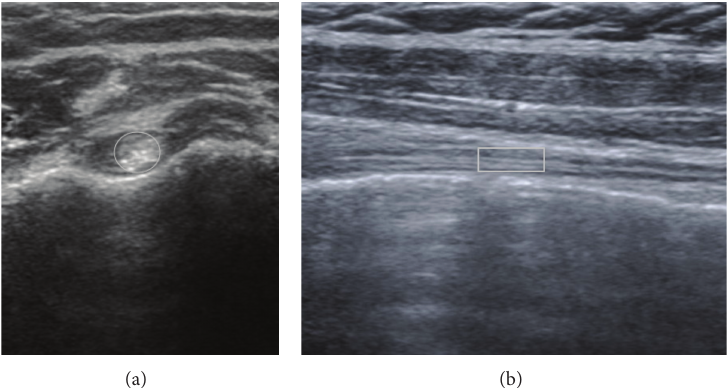
Figure 1: Biceps ultrasound. (a) Transverse view of the biceps tendon showing hypoechogenicity surrounding the bicipital tendon. The ROI was defined in a circular area, which covers the biceps tendon sheath. (b) The hypoechogenicity pattern among the biceps tendon is shown in this longitudinal view. The ROI was selected to be in the part of the biceps tendon with the most significant fluid accumulation, and the boarderpartofthissquareareaisdefinedasbeinglocatedonthebicepstendonsheath.ThegrayscalevaluesoftheROIweredirectlycalculated by using the PACS